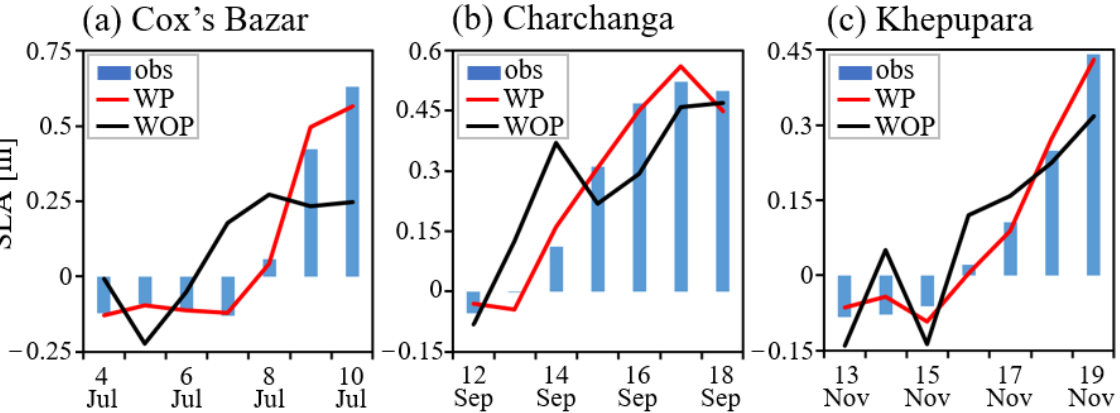
Figure 5. ( a ) The observed SLA (bar) and predicted SLAs for the prediction with precipitation (WP, red line) and without precipitation (WOP, black line) at Cox’s Bazar for the case of ESL on 10 July 2006. ( b , c ) same as ( a ) but for Charchanga on 18 September 1997 and Khepupara on 19 November 1988, respectively.